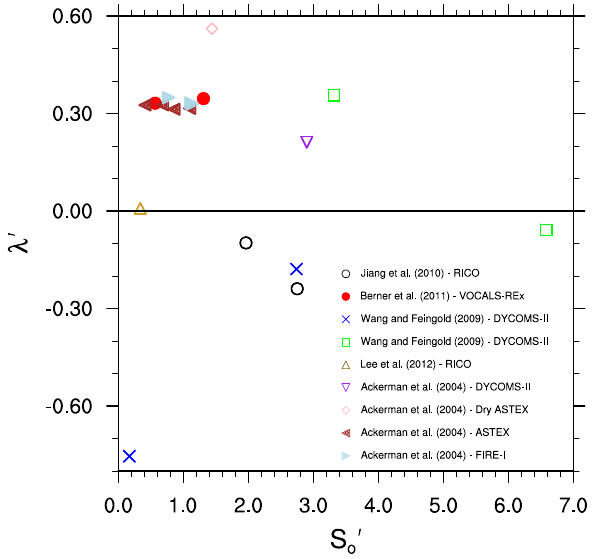
Figure 1. Scatterplot of λ 0 vs. S 0 o from previously published studies. The legend provides the reference that corresponds to each symbol. Note here that “prime” notation is used because not all of these studies provide enough detail to determine λ and S o . Specifically, S 0 o is dln R/ dln N a in Jiang et al. (2010), and λ 0 is dlnLWP / dln N d in Berner et al. (2011). For all other references, λ 0 = λ and S 0 o = S o